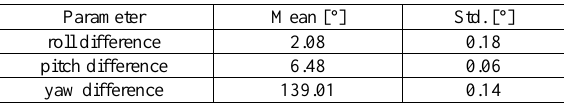
Figure 9. Calibration field with detail of target